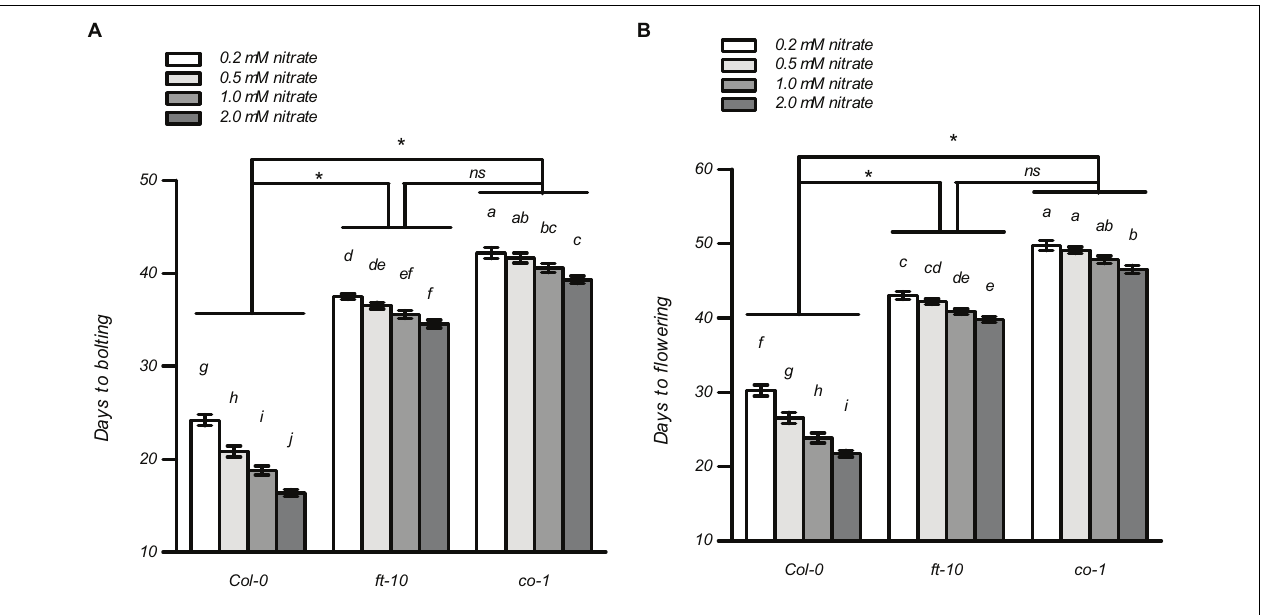
FIGURE 8 | Effects of nitrate availability on flowering in ft-10 and co-1 mutants under LD conditions. Days to bolting (A) and days to flowering (B) of the plants grown with different nitrate concentrations, were determined in an agar system under LD conditions (16 h light/8 h dark). Bars represent means ± standard deviations ( n = 20). Different letters indicate significant differences between the means, as determined using a two-way ANOVA followed by Tukey’s multiple comparisons test ( P < 0.05). Significant interactions between the photoperiod and genotype are indicated by an asterisk (* P < 0.05; ns,